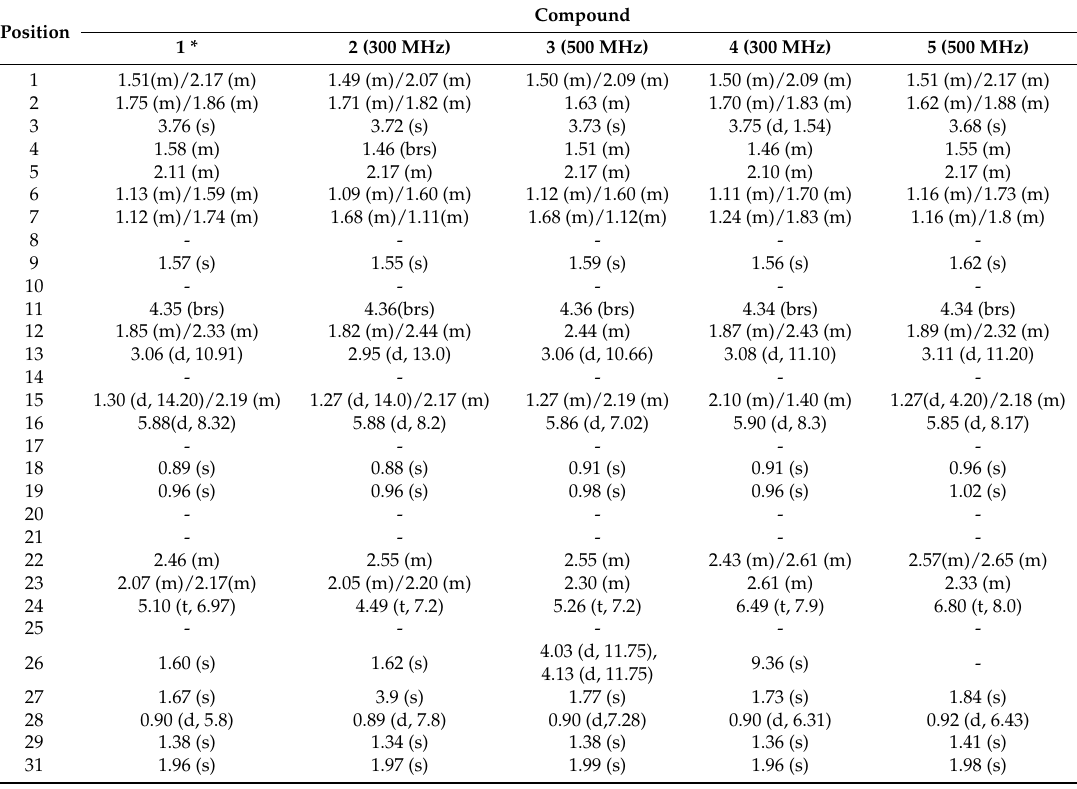
Table 1. 1 H-NMR data of fusidic acid and the isolated metabolites. δ H ppm ( J = Hz). Position